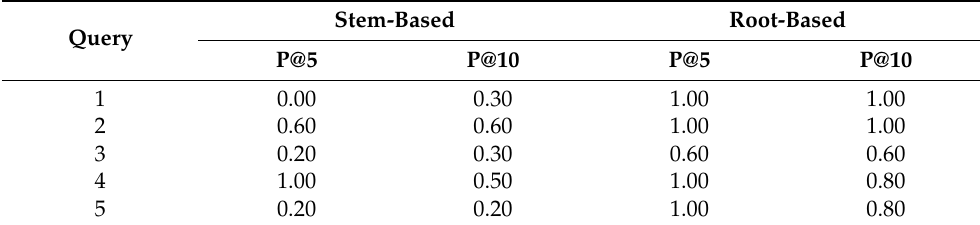
Table 11. Precision for stem-based and root-based representation.